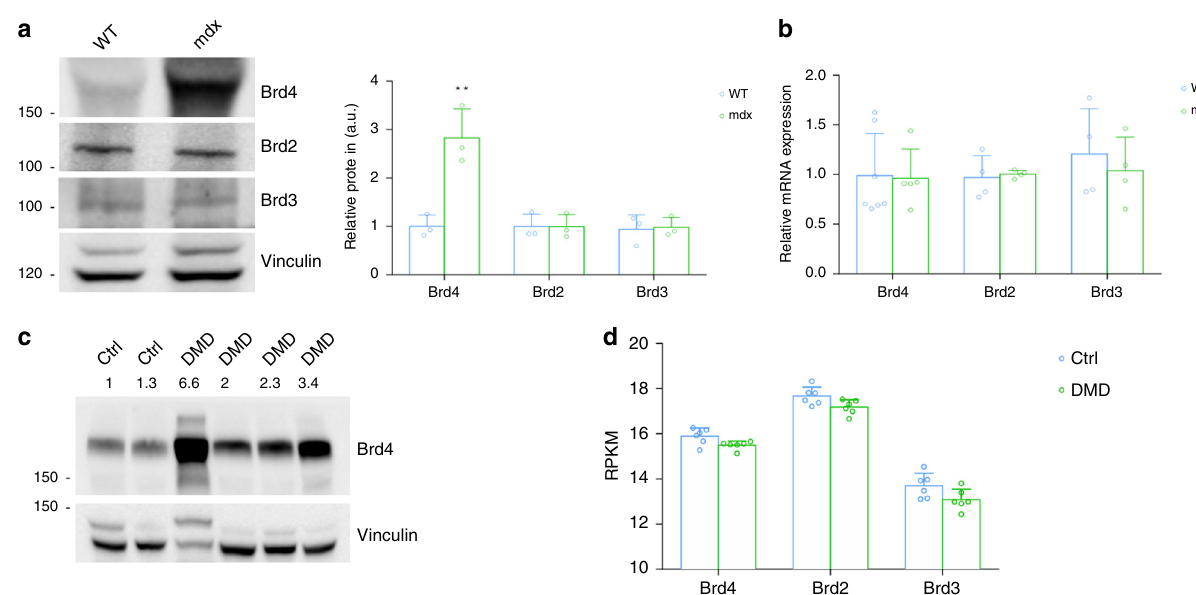
Fig. 1 BRD4 protein levels are higher in DMD and mdx muscles. a Representative images for immunoblot of BRD2, BRD3, and BRD4 in WT and mdx mice. Vinculin is used as a loading control. Right panel, signal quanti fi cation was performed with ImageJ. Data are expressed as the mean ± SD, n = 3, **denotes P < 0.01 was determined by using unpaired two-sided t -test. a indicates statistical signi fi cance compared to the control group. b RNA of control and mdx mice was analyzed for BRD2 (WT, n = 4; mdx, n = 4), BRD3 (WT, n = 4; mdx, n = 4) and BRD4 (WT, n = 7; mdx, n = 5) levels by qRT-PCR. Data were normalized against HPRT. Data are expressed as the mean ± SD, statistical signi fi cance was calculated using unpaired two-sided t -test. c Immunoblot analysis of paravertebral muscle specimen from Duchenne patients ( n = 4) and healthy controls ( n = 2). Normalized band intensity in immunoblots is reported above signals. d RPKM expression levels of BRD4 transcript in previously reported RNA-Seq dataset for DMD ( n = 6) and healthy donors ( n = 6). Data are expressed as the mean ±